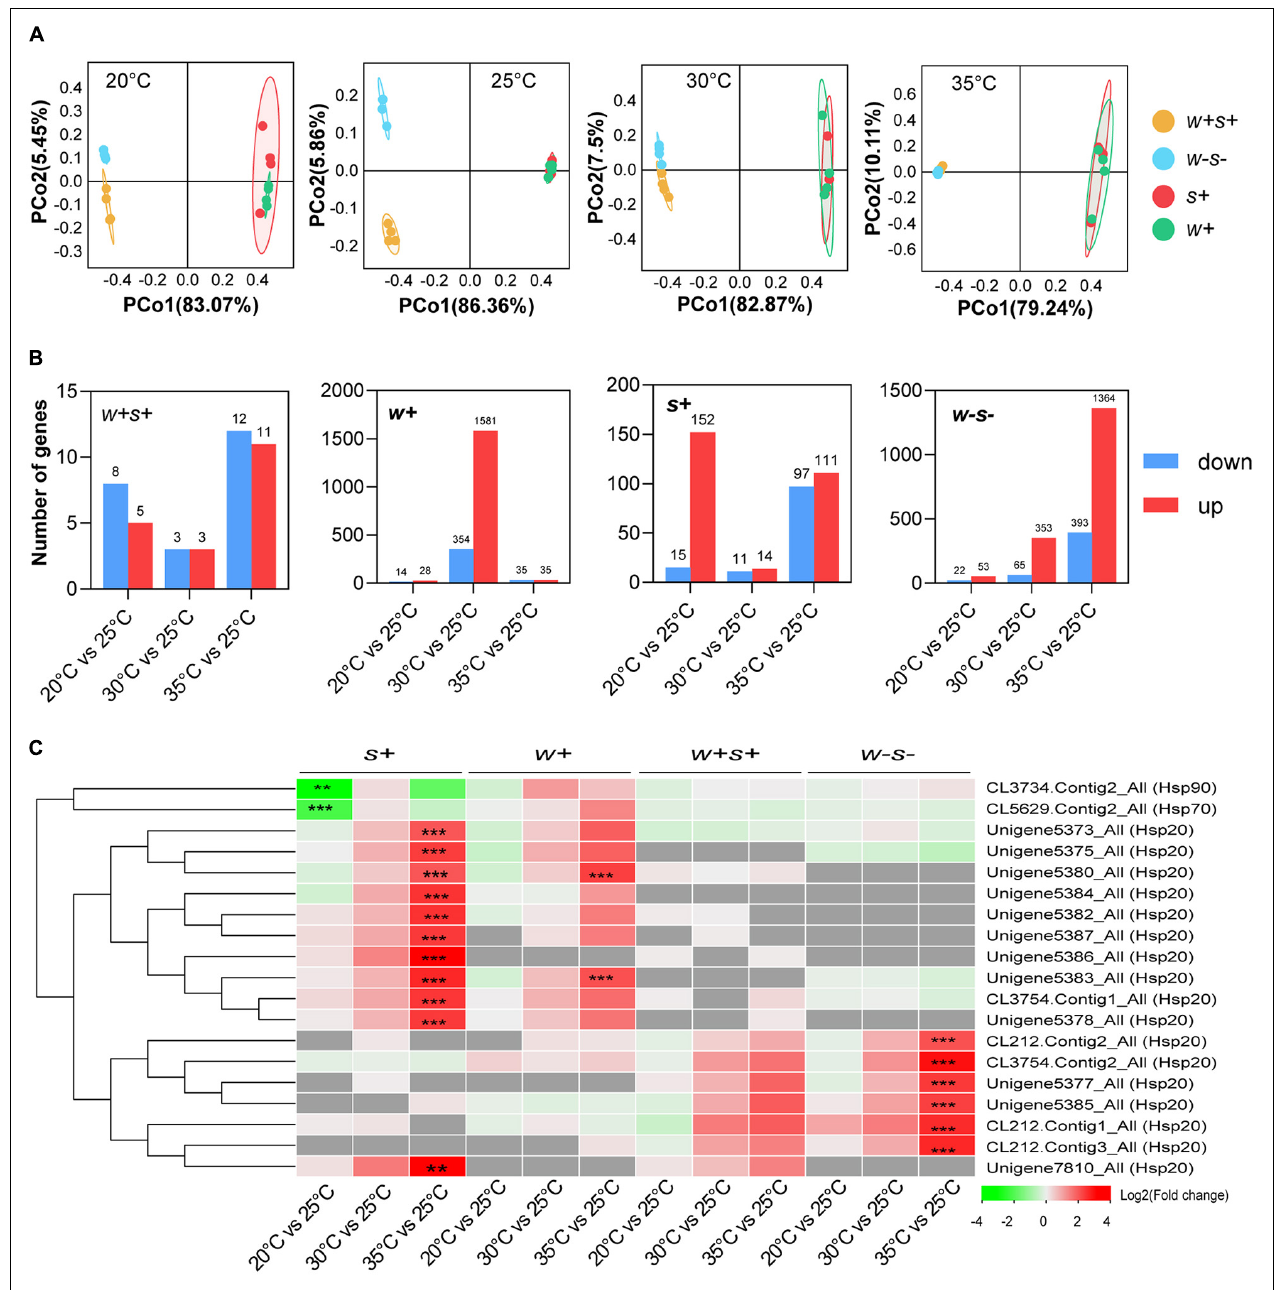
FIGURE 5 | Transcription response of four female adult spider mite strains following 6 h of different temperature exposures. (A) Principal components analysis (PCoA) of gene expression patterns of four spider mite strains under 20, 25, 30, and 35 ◦ C. (B) Number of differentially expressed genes (DEGs) with fold change > 2 and an FDR-adjusted p -value of < 0.05 for four spider mite strains under different temperatures. (C) Significantly differently expressed Hsp genes were analyzed by comparing each of 20, 30, and 35 ◦ C vs. the control (25 ◦ C) based on a threshold of > 2-fold change and an FDR-adjusted p -value of < 0.05. The gray squares in the heat map indicate that gene expression was absent. Asterisks indicate statistically significant differences (* p < 0.05; ** p < 0.01; and *** p < 0.001).